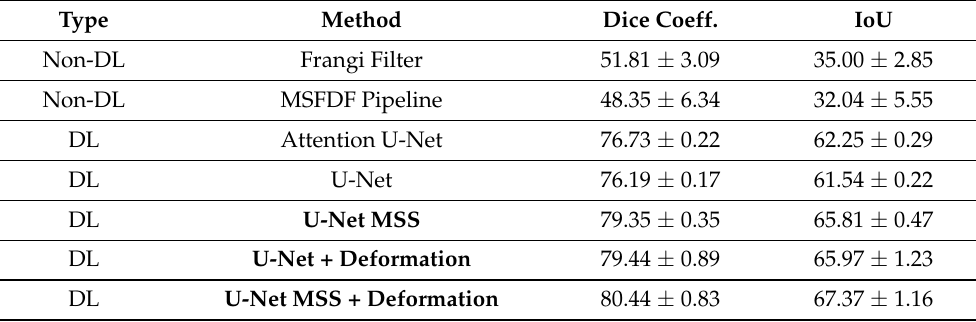
Table 1. Comparison of metrics for Non-Deep Learning and Deep Learning methods. Type Method Dice Coeff. IoU Non-DL Frangi